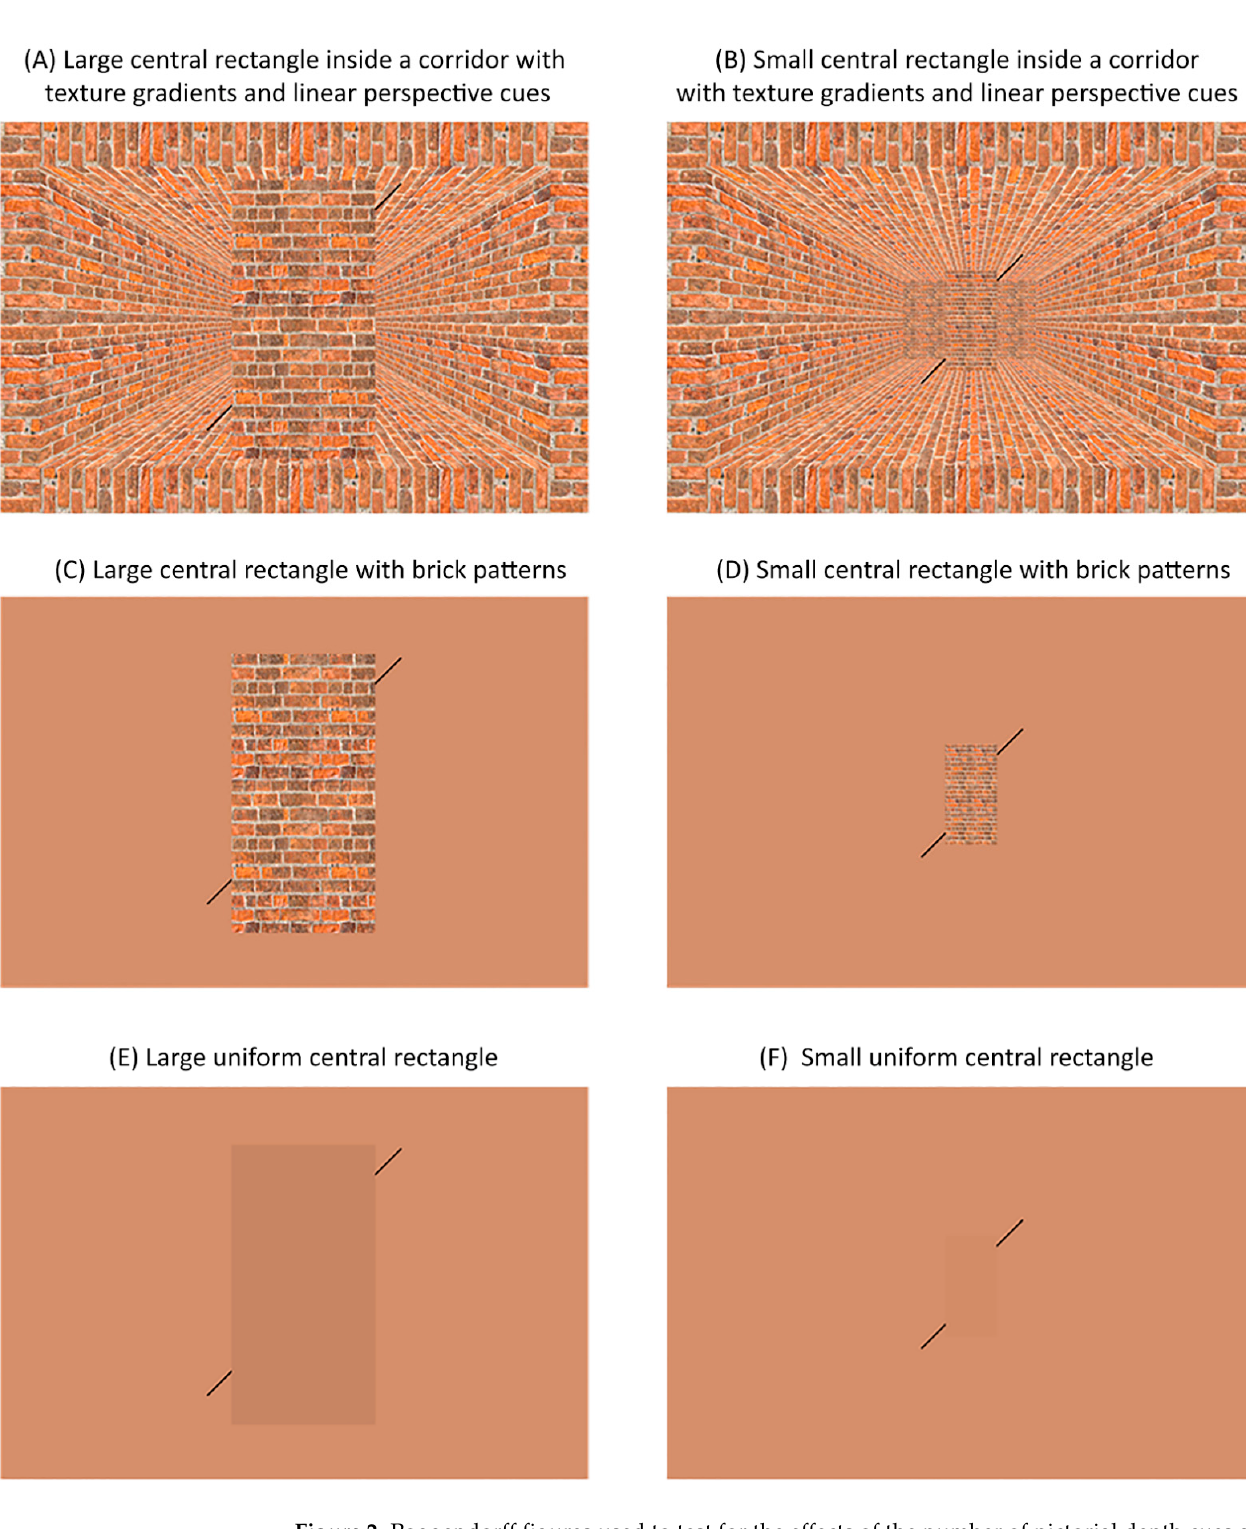
Figure 2. Poggendorff figures used to test for the effects of the number of pictorial depth cues and central rectangle size on the magnitude of the Poggendorff illusion in experiment 3. In experiment 3, we presented central rectangles composed of bricks in a corridor rich in texture and linear perspective depth cues ( A , B ), central rectangles composed of bricks on a uniform background ( C , D ) and central rectangles of a uniform colour on a uniform background ( E , F ). The central rectangles were presented either in large ( A , C , E ) or small ( B , D , F ) sizes, corresponding to positions in the front and the back of the corridor background,